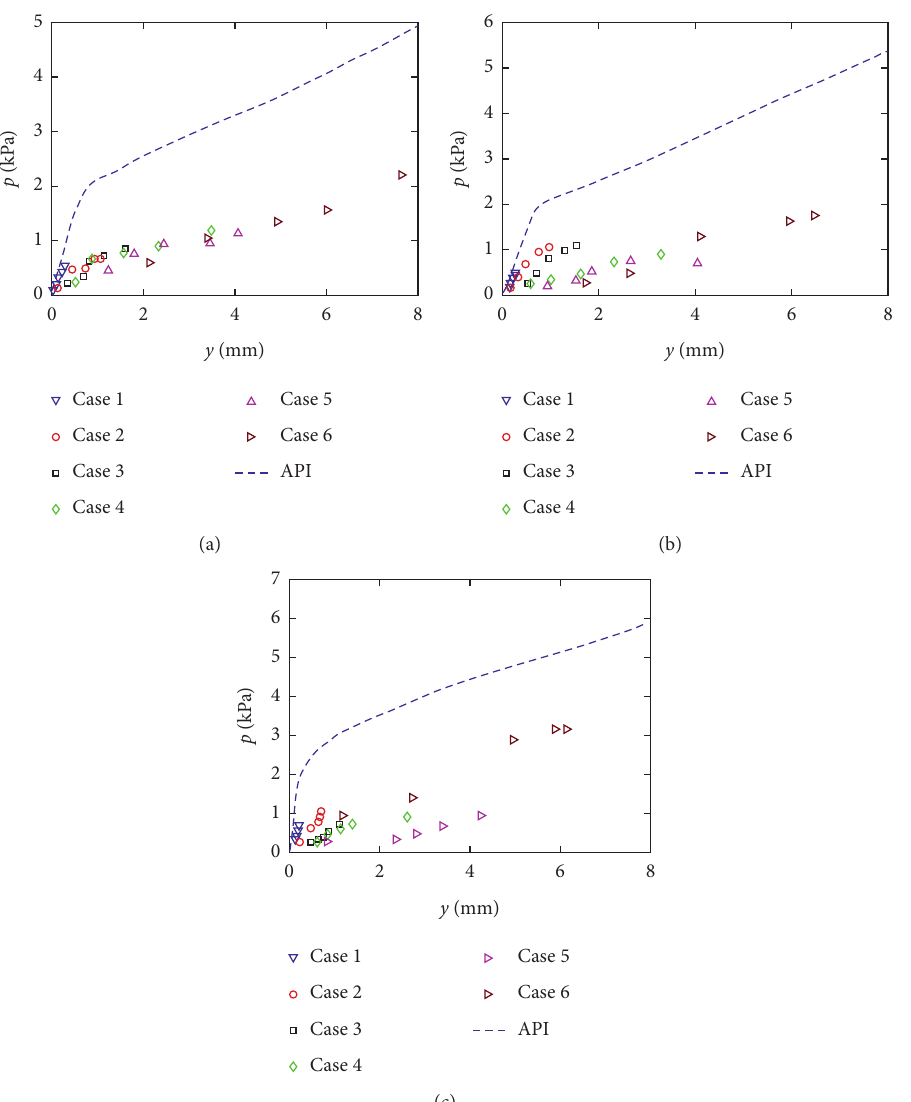
Figure 14: The test results were compared with API: (a) 1 D ; (b) 2 D ; (c) 3 D